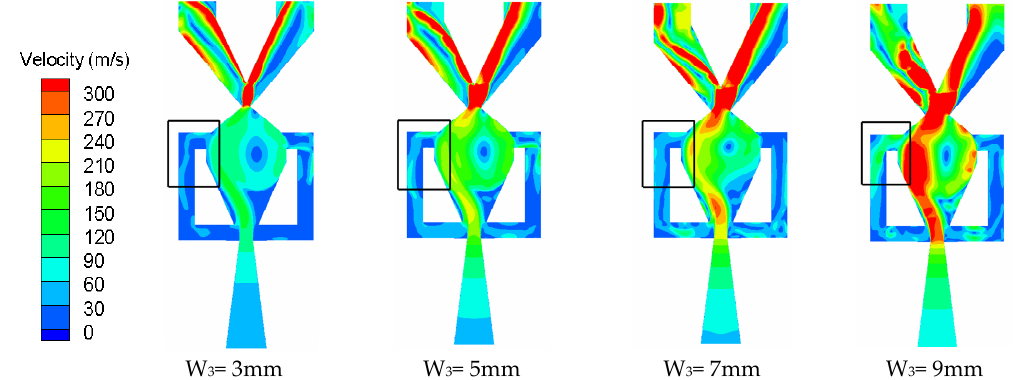
Figure 11. The velocity of oscillators with different structures.